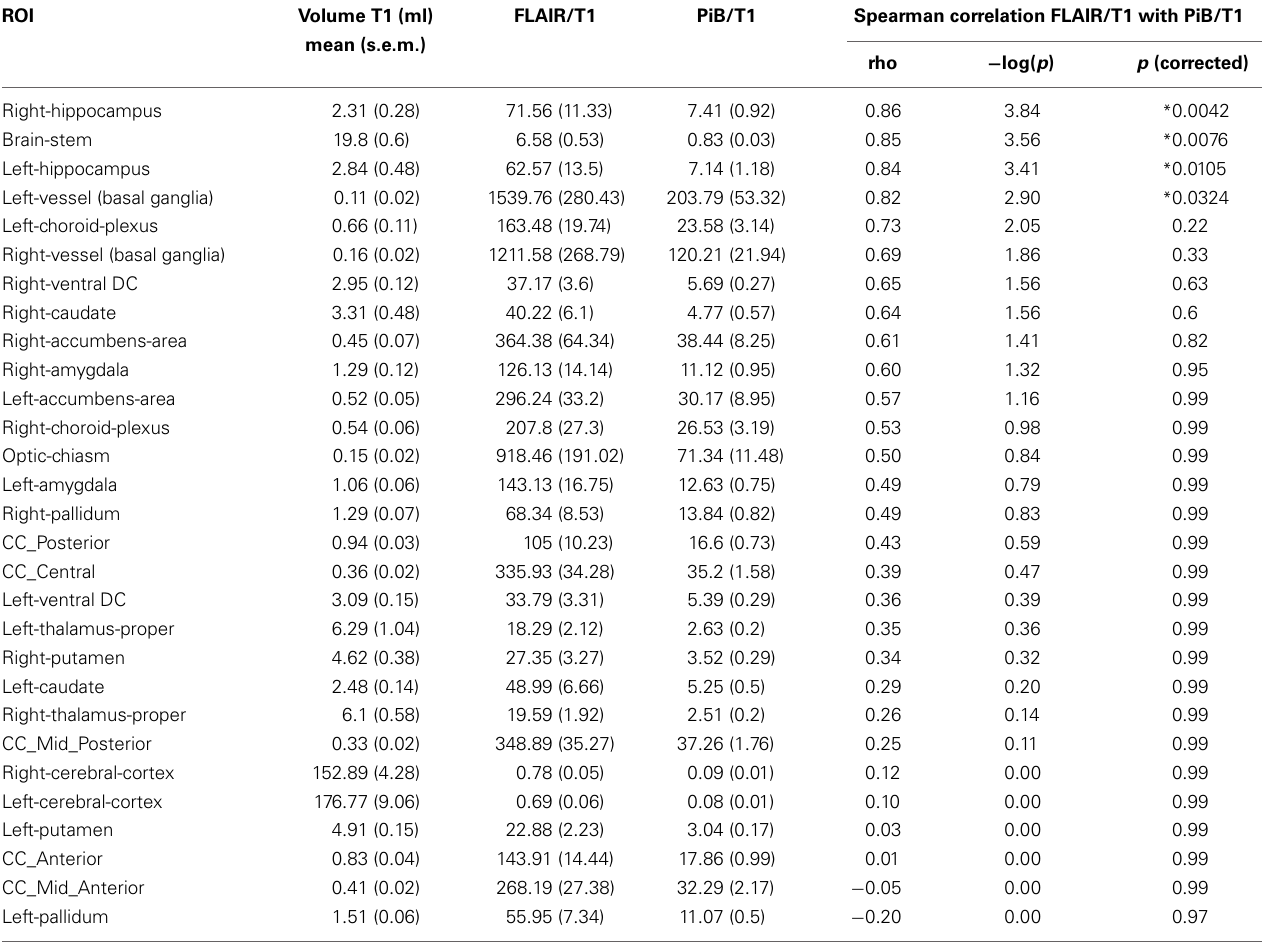
Table 2 | Volumes of brain structures as derived from the 7T T1 MPRAGE images as well as mean regional PiB-PET and FLAIR intensities, normalized to